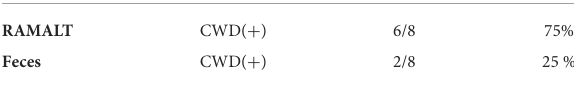
TABLE 1D CWD detection with RT QuIC in RAMALT and feces for white-tailed deer with prion detection CWD ( + ) in only lymph node with immunohistochemistry.